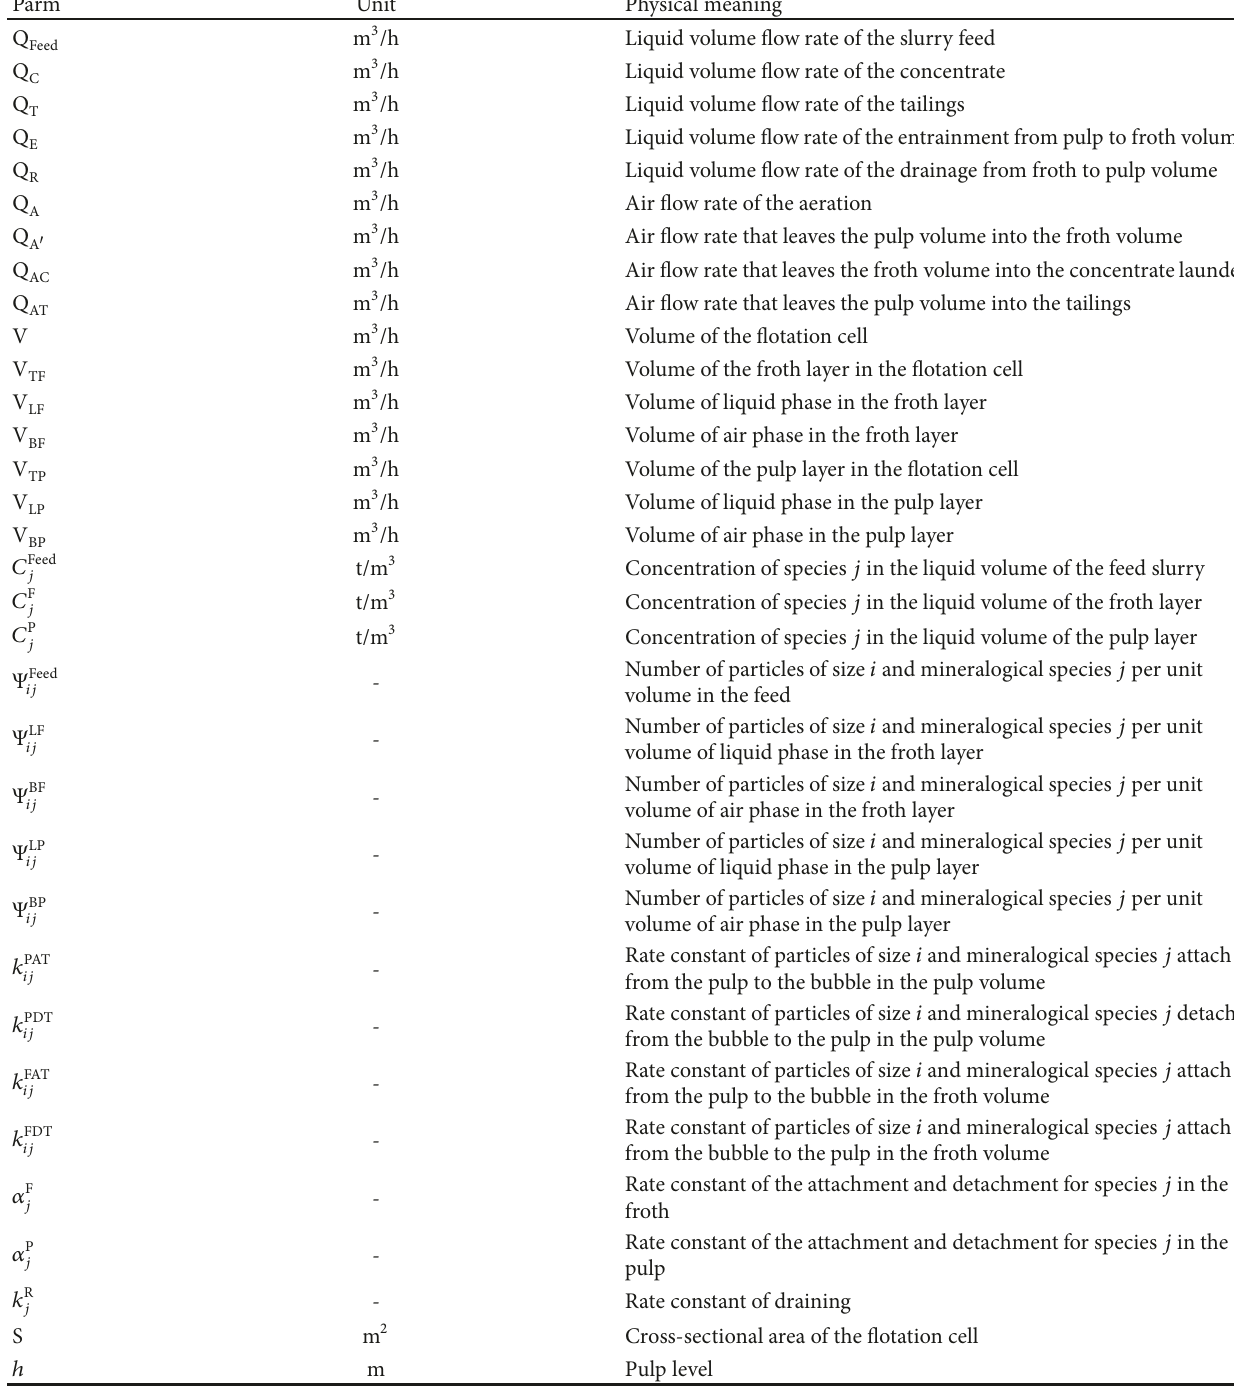
Table 1: List of model parameters and process